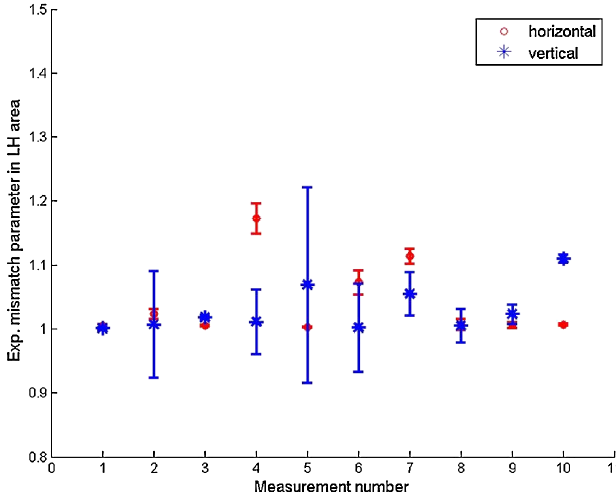
FIG. 5. Betatron mismatch parameter measured at one location in the LH area vs measurement number. Each value is the result of a single measurement of the Twiss parameters. The mismatch parameter is measured after the matching loop has been per- formed with ELEGANT and the quadrupole strengths applied in the LH area. (Notice that central values smaller than 1 have no physical sense: the full range of the vertical axis is used to show the full error bars associated with the the (cid:3) 10 (cid:1) m shot-to-shot variation of the rms beam size (the quadrupole scan is usually performed over many shots, at the repetition rate of 10 Hz). We have noticed that the quality of the beam optics matching process deteriorates